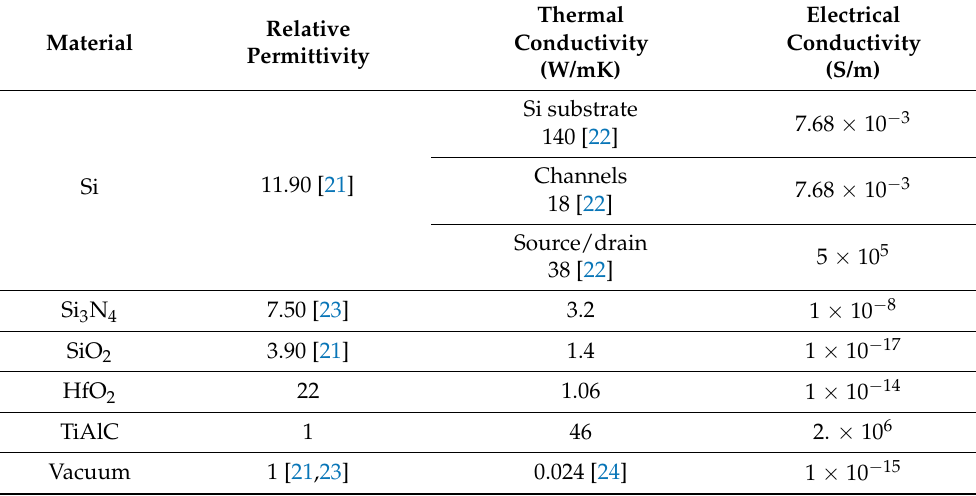
Table 2. Material properties for